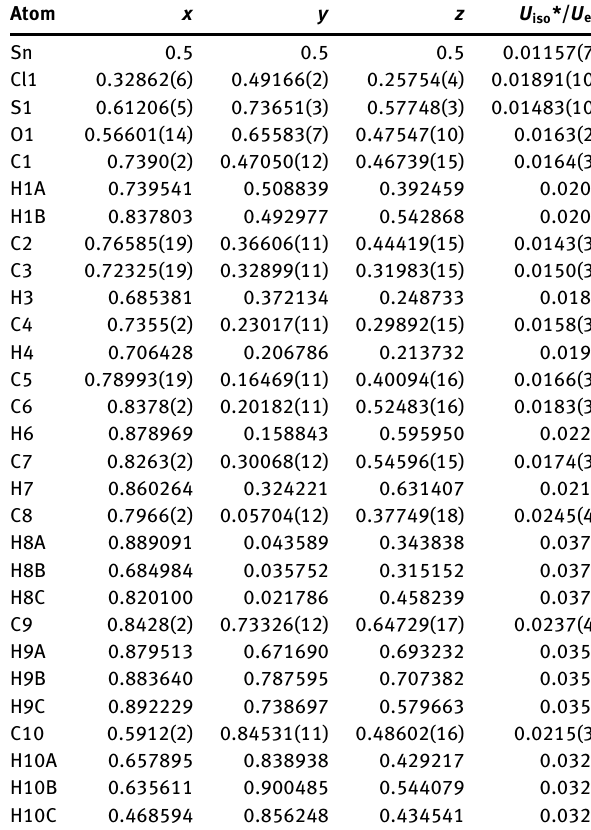
Table 2: Fractional atomic coordinates and isotropic or equivalent isotropic displacement parameters (Å 2